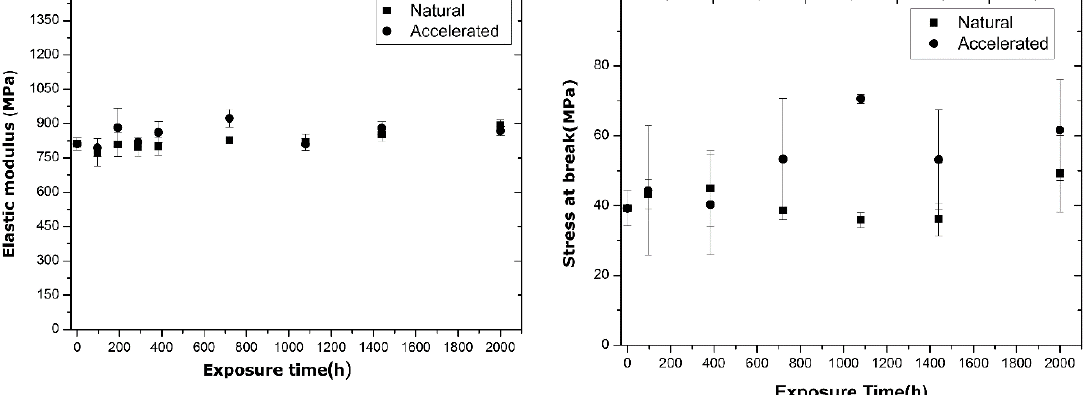
Figure 5. The elastic modulus as a function exposure time for natural and accelerated photoaging.